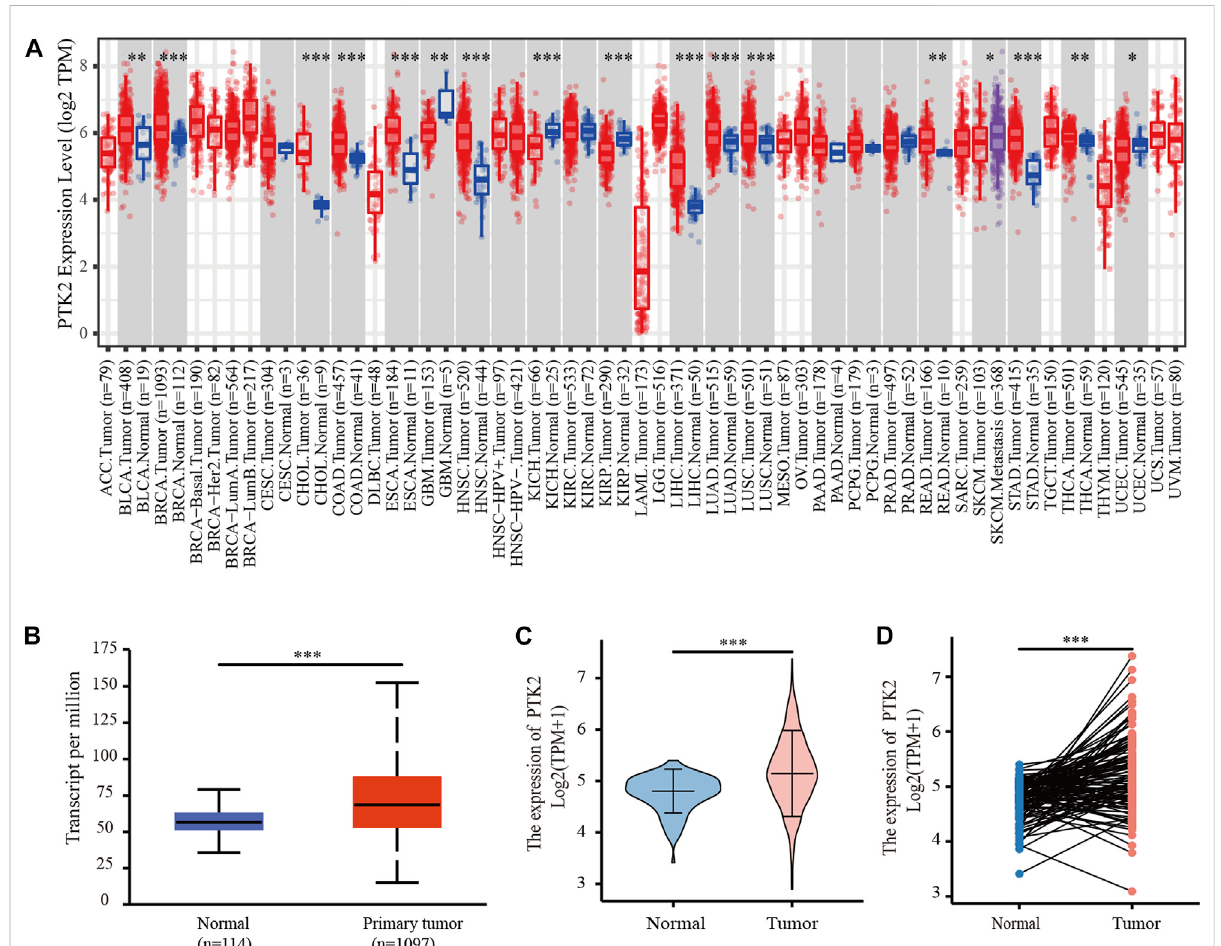
FIGURE 1 ExpressionofPTK2inbreastcancer. (A) ExpressionofPTK2indifferentcancersintheTIMERdatabase. (B) PTK2expressioninbreastcancerwas assessed by using the UALCAN database. (C) PTK2 expression levels in breast cancer from the TCGA database. (D) PTK2 expression in paired tissues. * p < 0.05 and *** p <